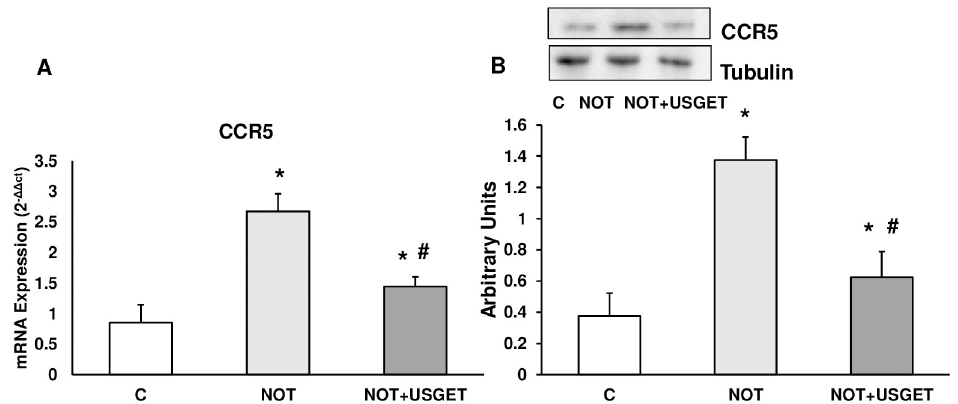
Fig 4. Rat muscle without notexin (C) or with notexin (NOT) or notexin with USGTE (6 mA) (NOT+USGTE) was collected to determine A: CCR5 mRNA expression and B: CCR5 protein expression by Wester-blot. A representative immunoblot is shown in the panel. CCR5 and Tubulin cropped from different parts of the different gels. Values are means ± SD from five independent experiments. � p < 0.04 vs. control. #p < 0.04 vs. notexin.